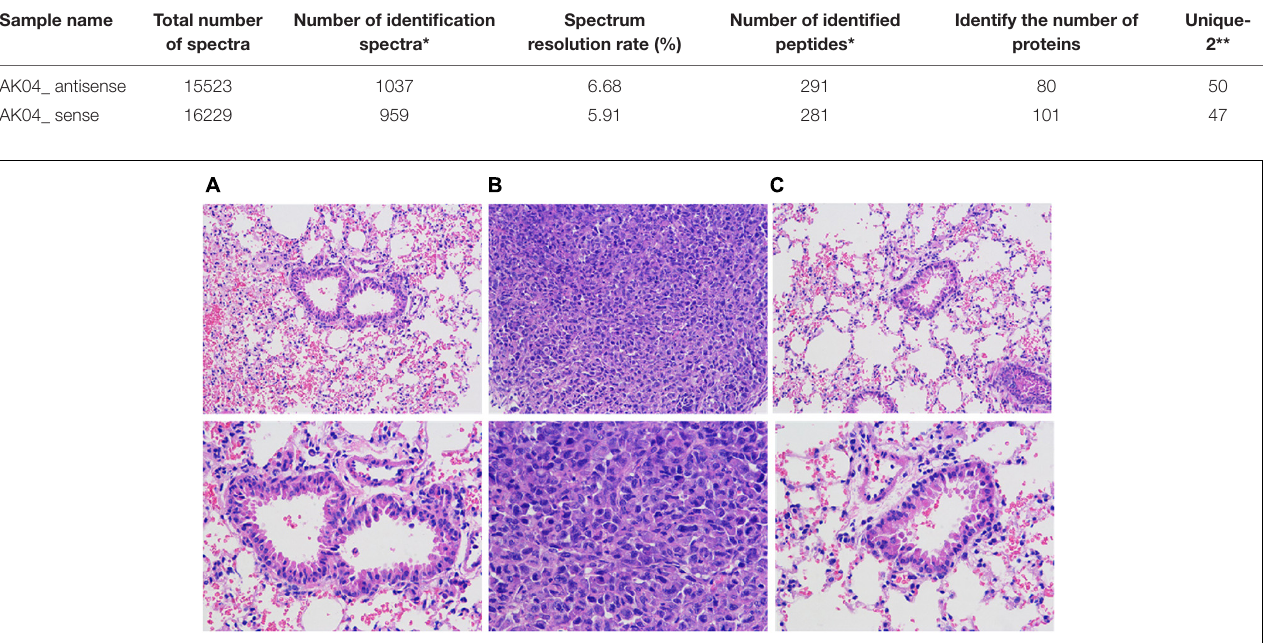
plus mass spectrometer for database search, please refer